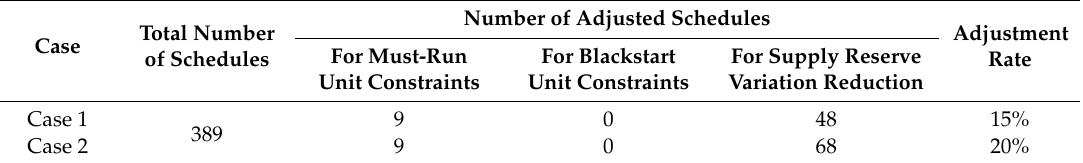
Table 5. Comparison of number of adjusted generator maintenance schedules for Cases 1 and 2.